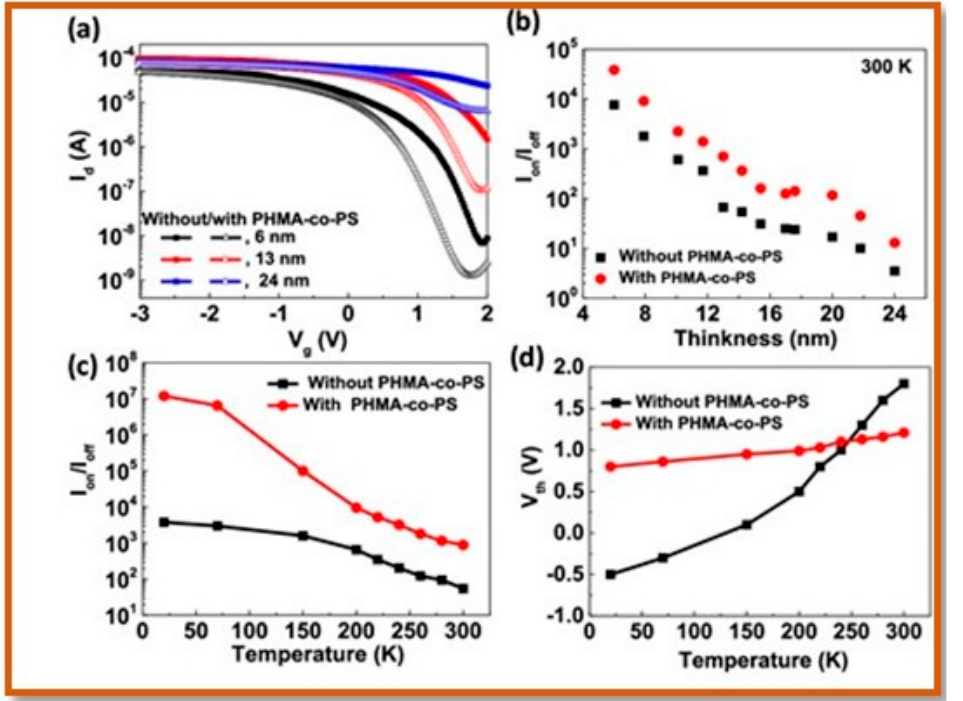
Figure 19. ( a ) Transfer characteristics of the 0.16 µm BP transistors with three different thicknesses before and after PHMA-co-PS encapsulation with Vd = − 0.05 V at 300 K. ( b ) Comparison of the on/off ratios for encapsulated and non-encapsulated BP FETs versus different BP flake thicknesses. Comparison of ( c ) on/off ratio and ( d ) Vth for 13 nm BP devices before and after PHMA-co-PS encapsulation from 300 to 20 K. Reprinted (adapted) with permission from ACS Appl. Mater. Interfaces [134]. Copyright 2019 American Chemical Society.